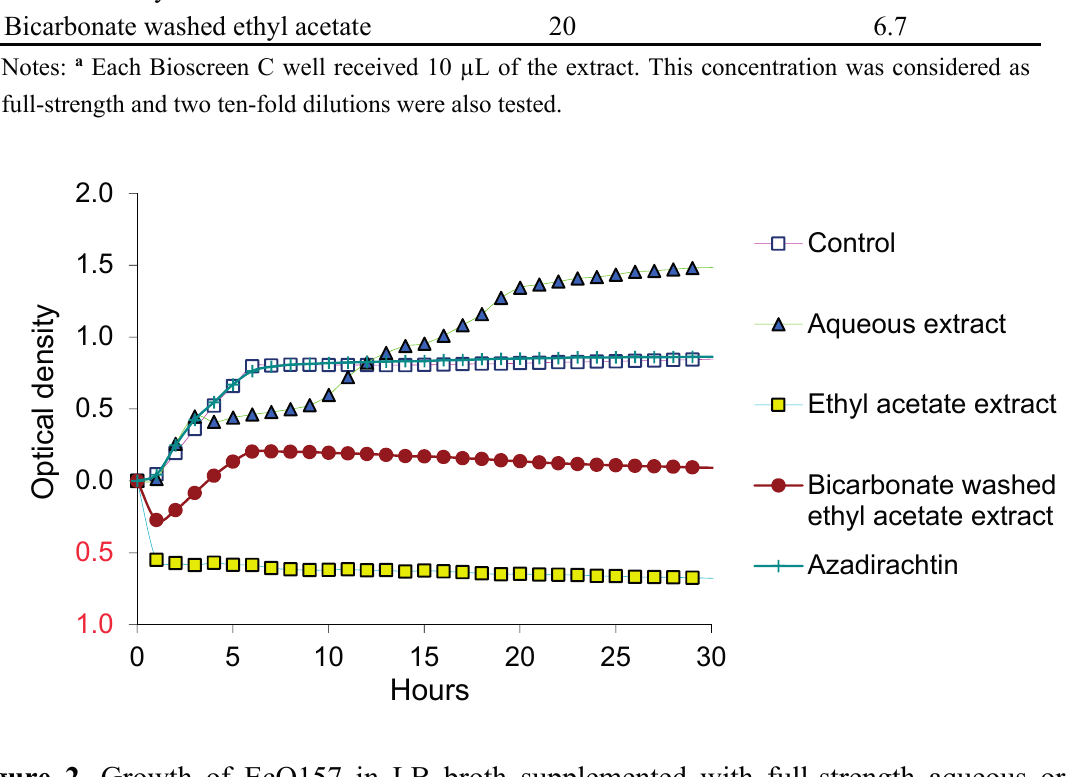
Figure 2. Growth of EcO157 in LB broth supplemented with full-strength aqueous or organic extracts of neem leaf. Optical densities at all sampling intervals were corrected for zero-time values. A control well contained 10 µL ethanol and 20 µL inoculum.